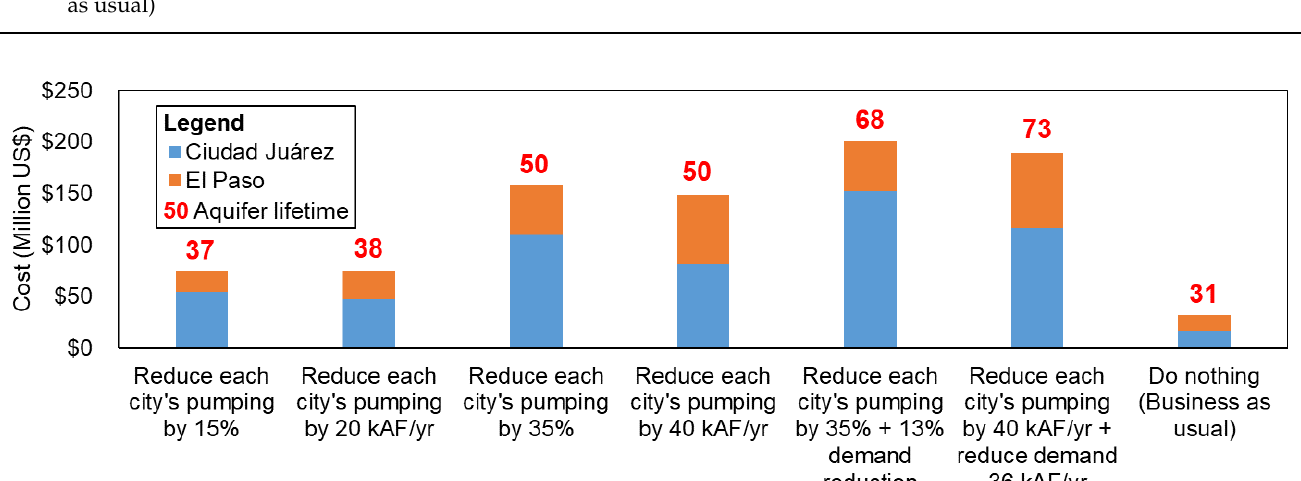
Figure 2. Costs of options for meeting a target reduction in pumping and associated depletion times (numerical values in red bold).